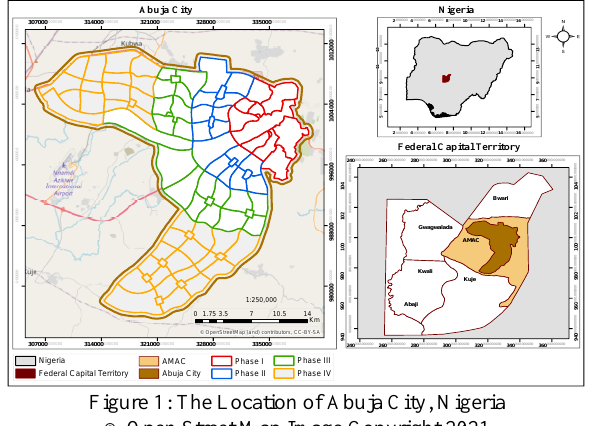
Figure 1: The Location of Abuja City,